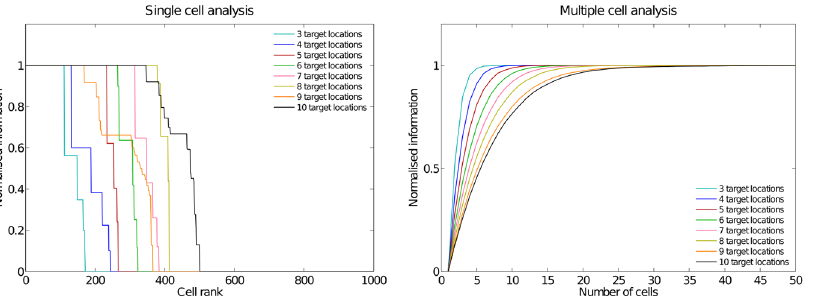
Figure 8. Information analysis as the number of target locations is increased. Analysis of the information conveyed by the output (fourth) layer neurons about the location of the visual target with respect to the hand. Values on the y-axis were normalised by the maximal information possible, log 2 (number of target locations) , for each simulation. The single cell information analysis (left plot) shows that in all cases more than 10% of the neurons conveyed the maximal single cell information. The multiple cell information measures (right plot) were calculated using five cells for each stimulus that had the most single cell information about that stimulus. For simulations with three target locations this results in a population of 15 cells, while for ten target locations the multiple cell information analysis used 50 cells. It can be seen that in all cases the multiple cell information asymptotes to the (normalised) maximal value, confirming that all of the hand-object configurations are represented by the output cells.